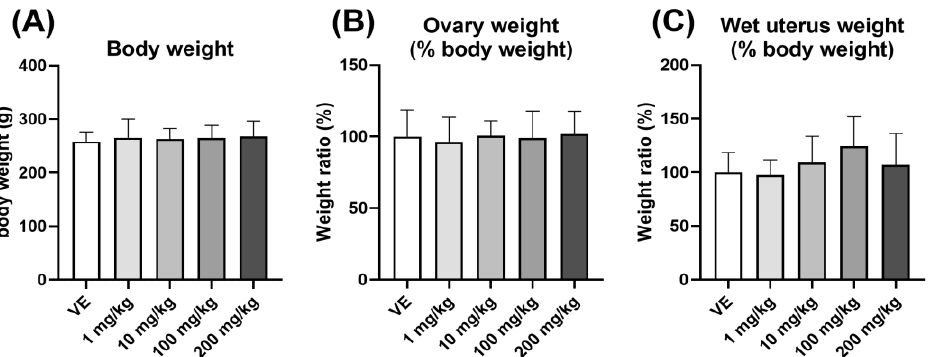
Figure 3. The body weight and organ weight of rats exposed to D5. ( A ) Body weights of rats; ( B ) ratio of ovary weight to body weight; ( C ) ratio of uterus weight to body weight. The values are expressed as means ± SD. VE—vehicle, N = 9~10.